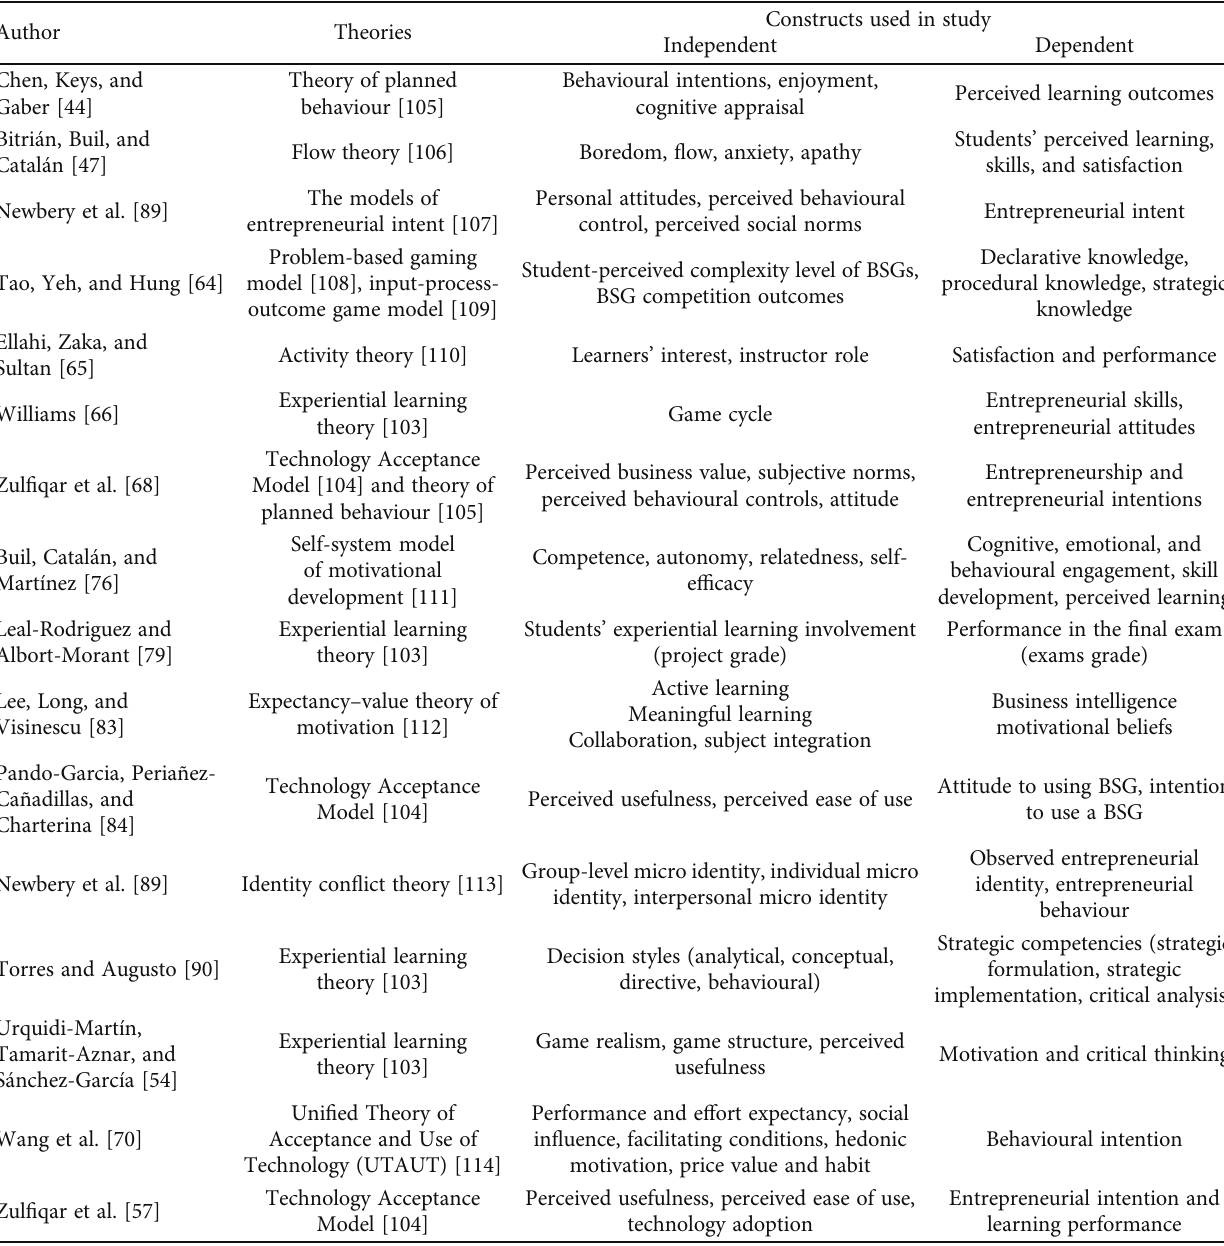
Table 6: Learning theories and the variable used in selected